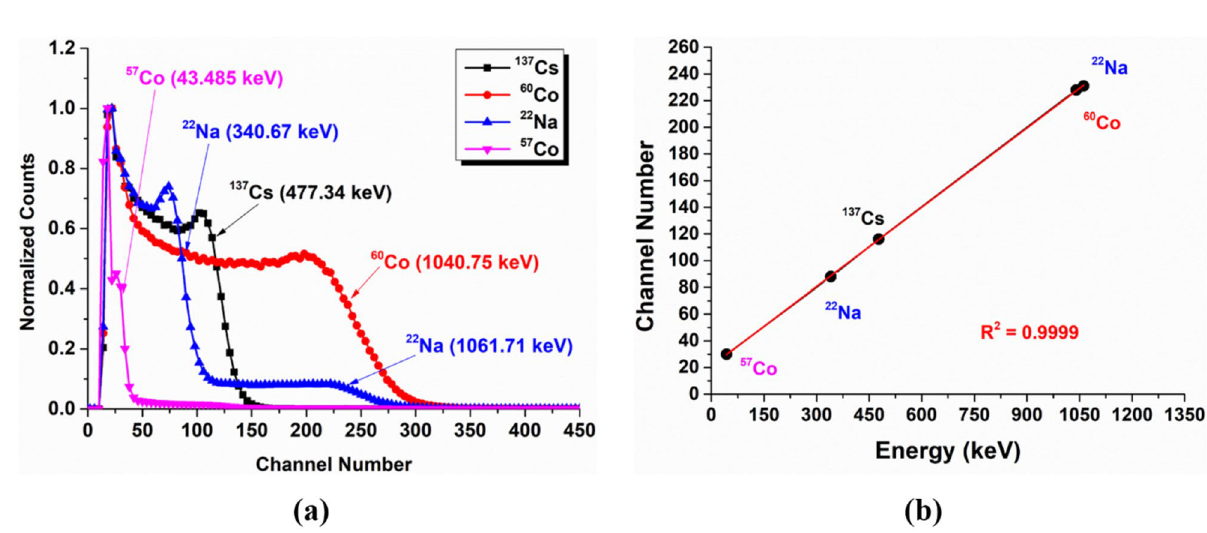
Figure 3. ( a ) Energy spectra of the stilbene scintillator array coupled to the SiPM array when irradiated by the gamma-ray sources shown. ( b ) Measured Compton edge position (in channel number) as a function of analytical Compton edge energy when the SiPM was operated at a 28 V bias voltage and a temperature of 28 ℃ . The Compton edge position was calculated at the channel number corresponding to 70% of the Compton peak for each of the gamma-ray